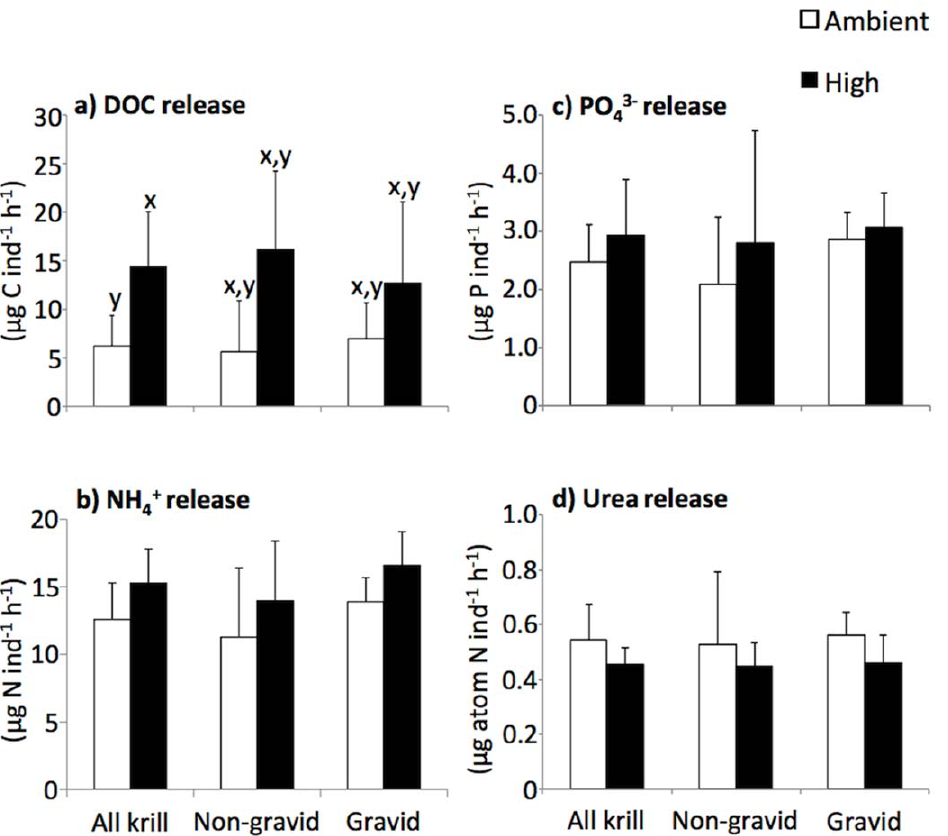
Figure 2. Euphausiasuperba organic and inorganic nutrient release rates. Dissolved organic carbon (DOC; a), ammonium (NH 4 + ; b), phosphate (PO 43 2 ; c), and urea (d) release rates of krill exposed to ambient and high ( (cid:2) xx =672 ppm) concentrations of CO 2 . Mean of n=5 for non- gravid and gravid krill and n=10 for all krill; error bars=2 6 standard error. For DOC release, x and y denote a significant difference between treatments (x . y, p , 0.05).